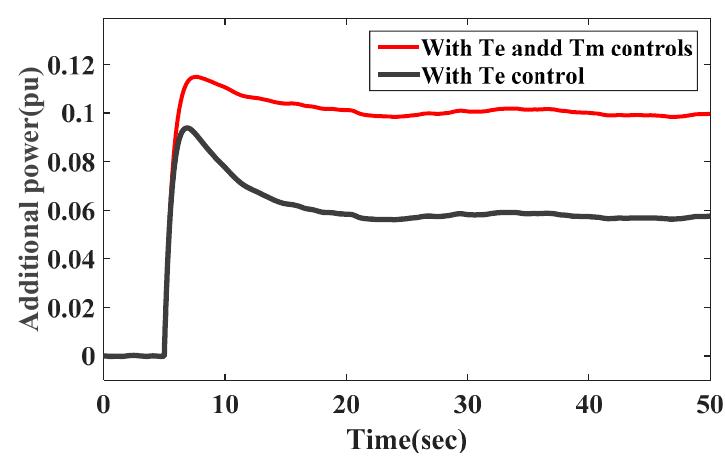
Figure 12. Additional power response of WTG with different torque control.